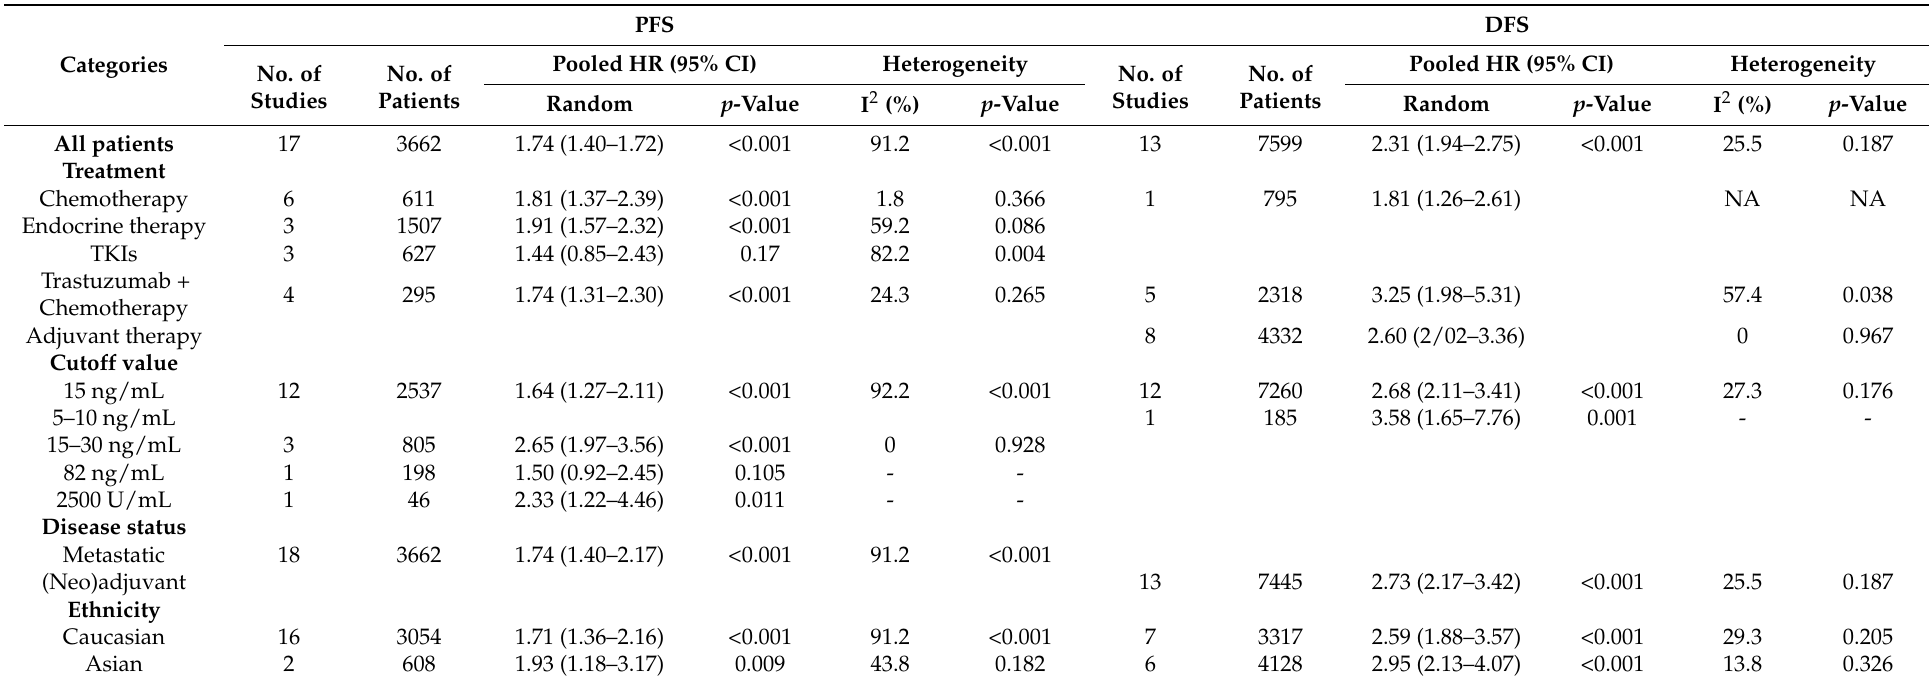
Table 2. Subgroup analysis of the pooled HR for the PFS and